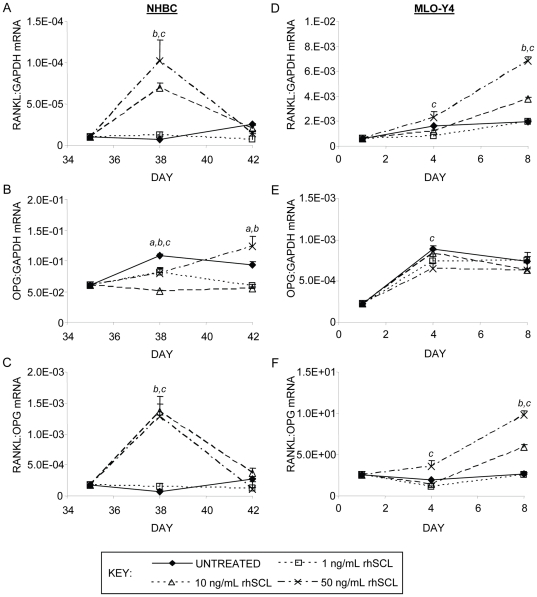
Effects on gene expression of acute exposure of osteocyte-like cells to rhSCL.Human osteocyte-like cultures, derived from NHBC cultured under mineralizing conditions for 35 days, or cultures of MLO-Y4 cells were cultured for 3 or 7 days in the absence of presence of rhSCL at 1, 10 or 50 ng/ml. Media and supplements were replenished at day 3. Total RNA was prepared and real-time RT-PCR performed to determine mRNA expression of A) human RANKL, B) human OPG or mouse Rankl (D) and Opg (E). The ratios of RANKL∶OPG mRNA for NHBC (C) and MLO-Y4 (D) were also determined. Data shown are means of triplicate reactions ± SD normalized to expression of GAPDH mRNA. a, b and c indicate significant differences (p<0.05) to untreated control for rhSCL at 1, 10 and 50 ng/ml, respectively. Near identical results were obtained from 3 independent experiments using NHBC from different donors or MLO-Y4 cells.